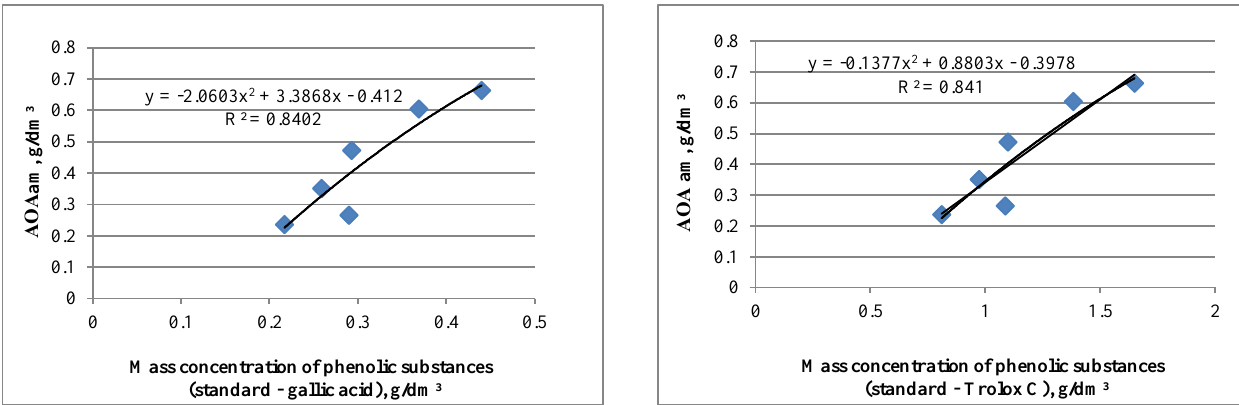
Figure 3. Correlation of the AOA am indicator of white table wine materials and the mass concentra- tion of phenolic substances (standard — gallic acid and standard — Trolox-C).